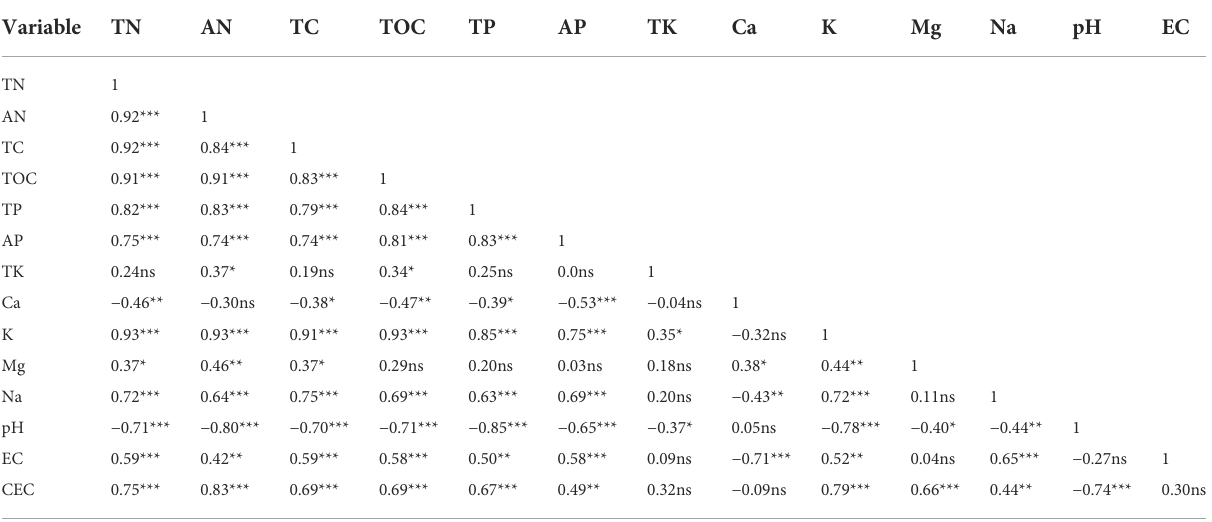
TABLE 4 Spearman ’ s correlation coef fi cients between soil chemical